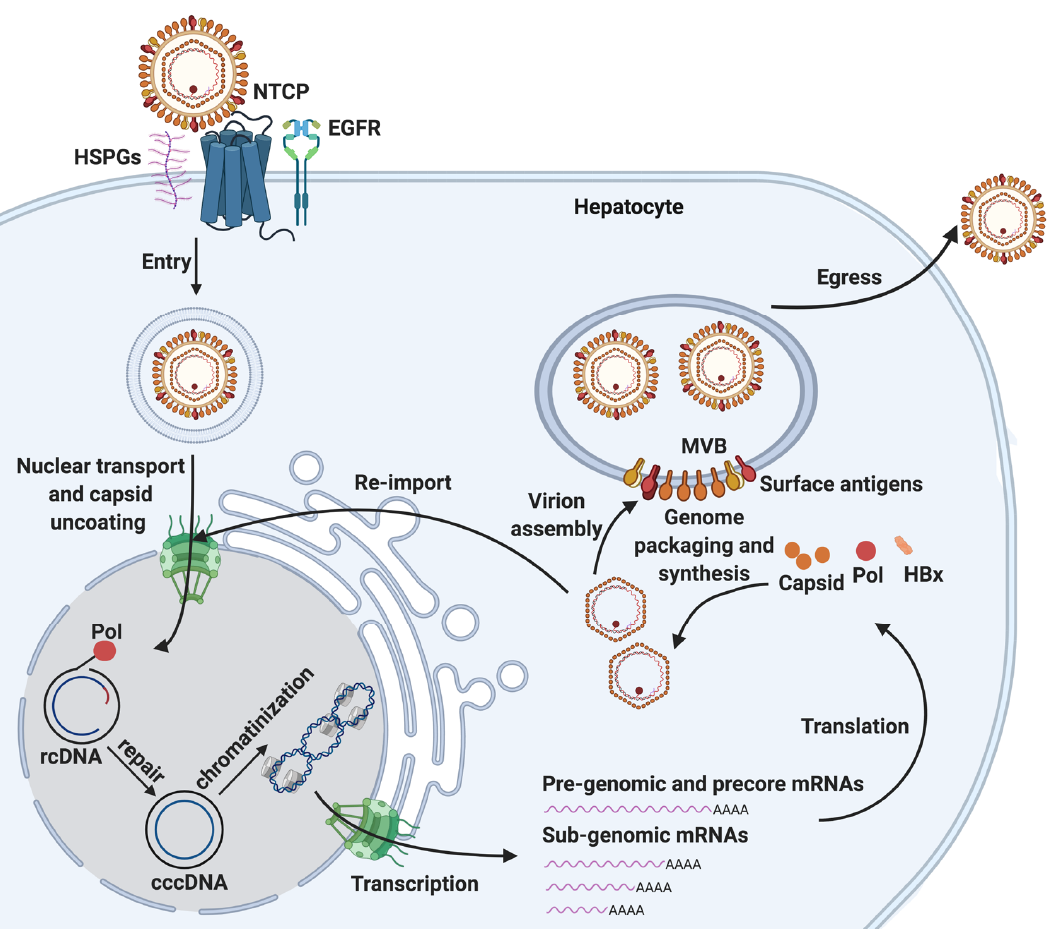
Figure 1. The HBV life cycle and cccDNA biogenesis. HBV life cycle is a multi-step process composed of viral entry, cccDNA biogenesis, progeny nucleocapsid production, virion formation, and egress. Viral entry is mediated by NTCP, heparin sulfate proteoglycans (HSPGs, such as glypican 5), and EGFR on the surface of hepatocytes. cccDNA biogenesis is an essential process to establish infection, which consists of three distinct steps: nuclear transport of rcDNA and uncoating, repair of rcDNA to form cccDNA, and cccDNA chromatinization. cccDNA can serve as the template for pre-genomic and precore mRNAs and multiple sub-genomic mRNAs, which can be translated to several viral proteins, including HBV POL, core antigen (capsid), surface antigens, HBx, and core-antigen related proteins (not shown). Progeny nucleocapsid production is initiated by the binding of HBV POL to pre-genomic mRNA, which triggers the packaging (encapsidation) and synthesis of rcDNA. The resultant nucleocapsids can either be re-imported into the nucleus, and the rcDNA repaired to form cccDNA and maintain cccDNA pool through the intracellular amplification pathway, or it can be enveloped in the multivesicular body (MVB) to complete virion assembly. Subsequent virion egress completes the HBV life cycle.